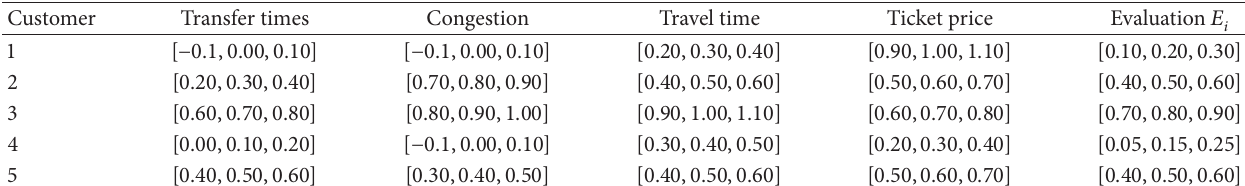
Table 9: Data of Example 27 (The customer evaluation).